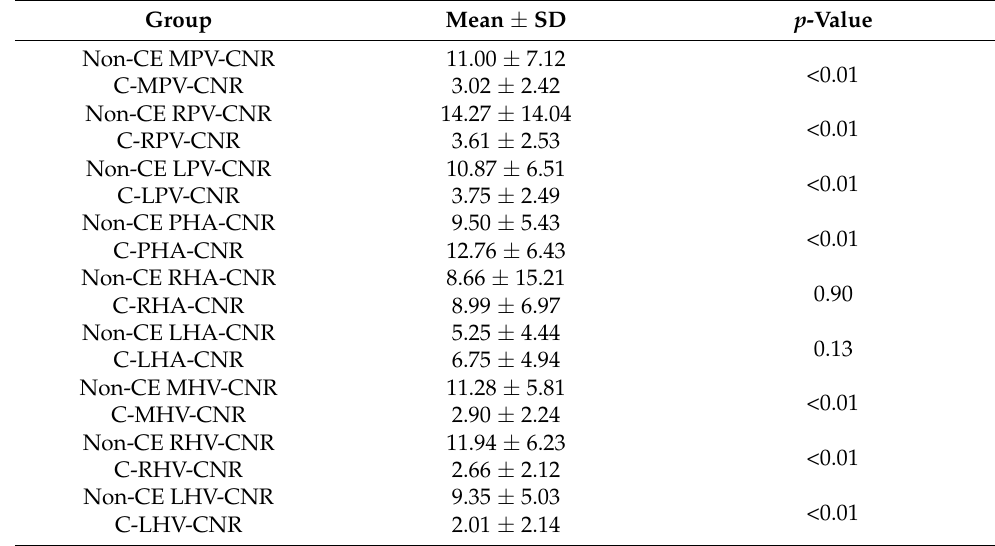
Table 3. Quantification of vessel signal intensity based on